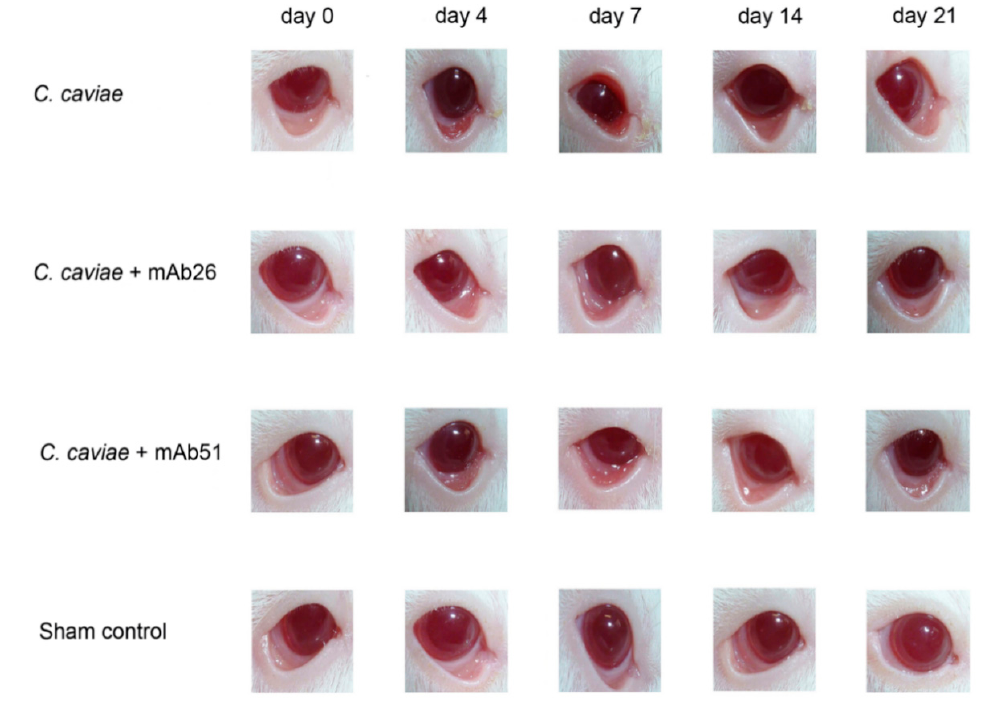
Figure 6. Representative photographs of guinea pigs’ conjunctiva at defined intervals (day 0, 4, 7, 14, and 21). The guinea pigs were infected with 1 × 10 4 IFU of C. caviae and 1 × 10 4 IFU of C. caviae preincubated with either mAb26 or mAb51 (10 µg/mL, 1 h/RT). Upon infection, the local treatment with corresponding mAb was performed daily until day 7 post-infection.